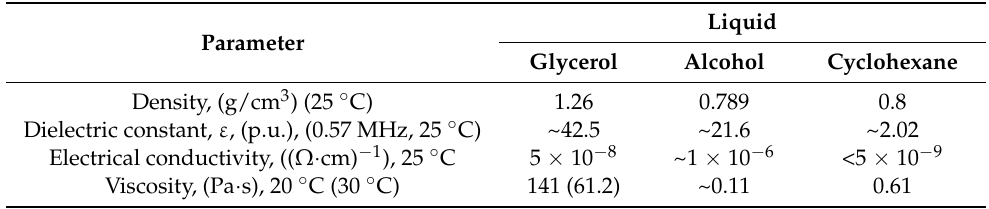
Figure 7. The cell for electrical conductivity measurements. Table 2. Physical parameters of glycerol, alcohol, and cyclohexane.